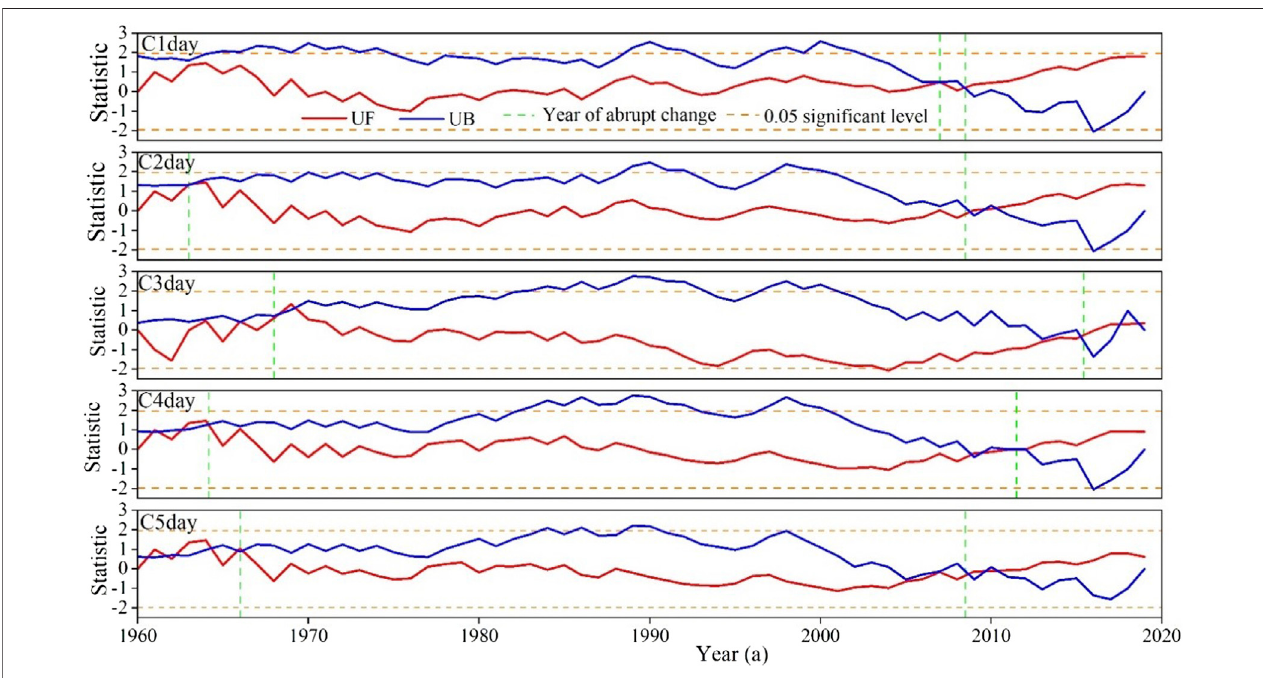
FIGURE 5 | Mann – Kendall (MK) mutation test for the series.